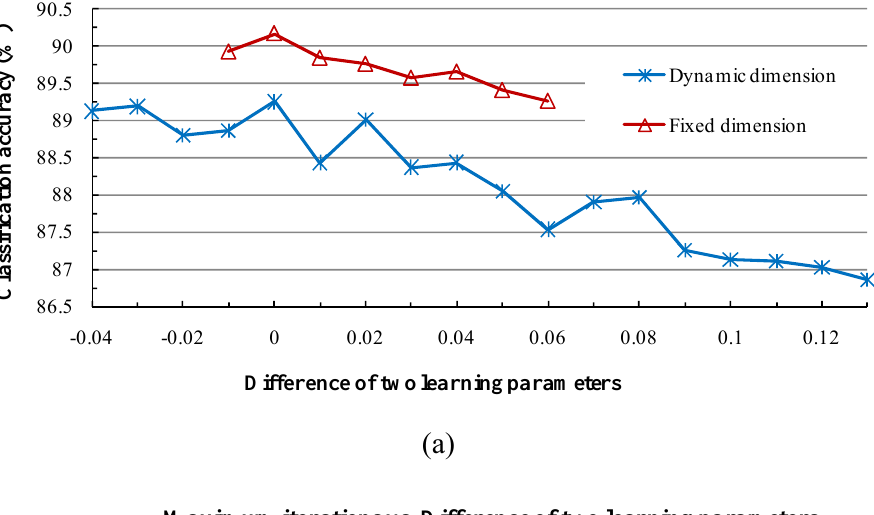
Maximum iterations vs. Difference of two learning